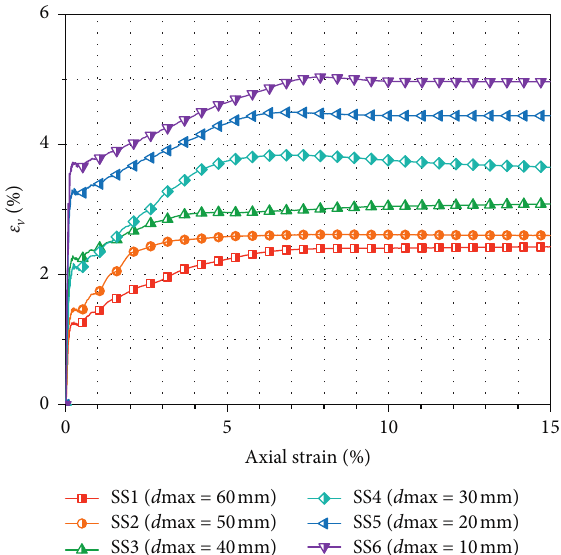
Figure 12: The volumetric strain-axial strain relationship curve of each scheme.